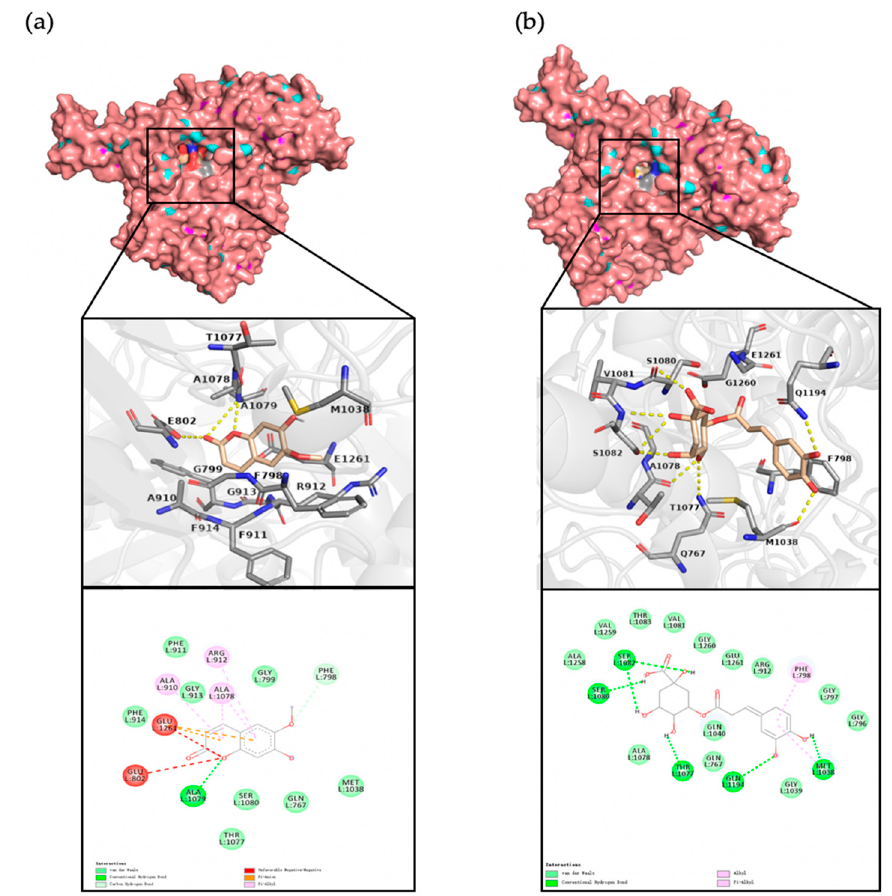
Figure 6. The docked complexes ( a ) scopoletin with XO and ( b ) chlorogenic acid with XO. Residues around inhibitor binding.